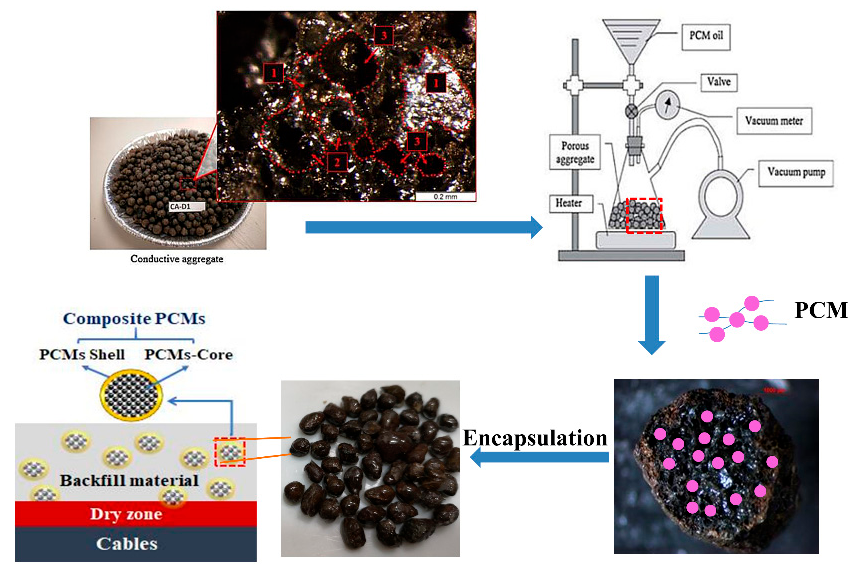
Figure 1. Schematic of the preparation of the encapsulated paraffin/CS composite phase change material (CPCM).